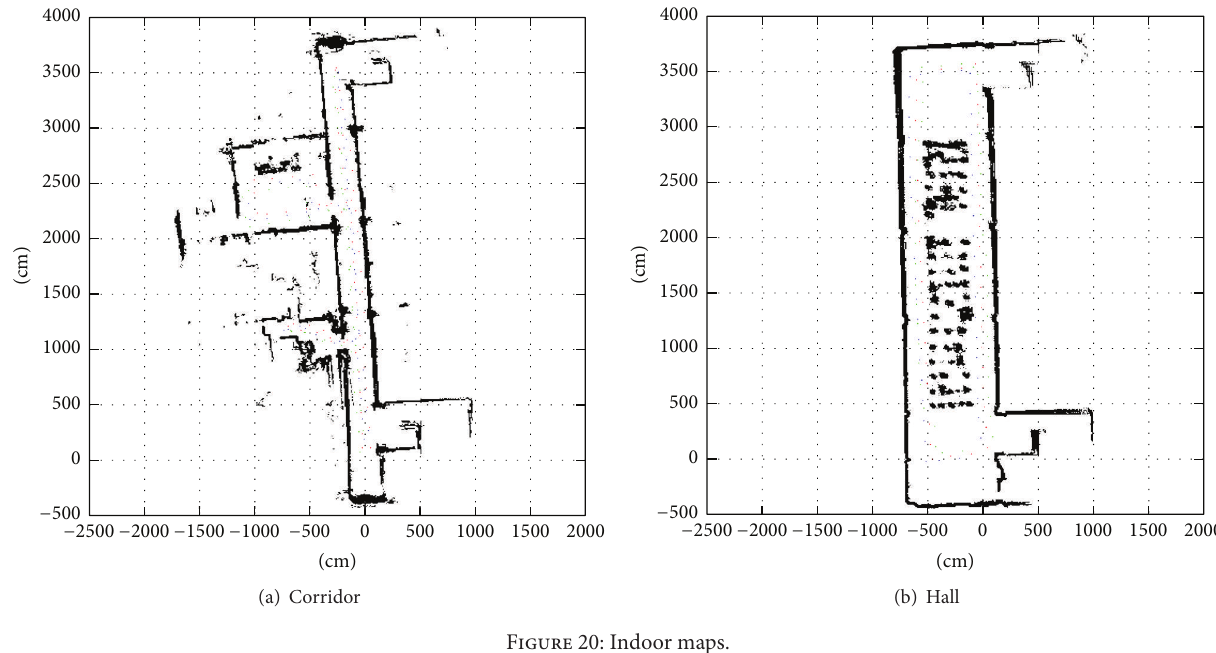
Figure 20: Indoor